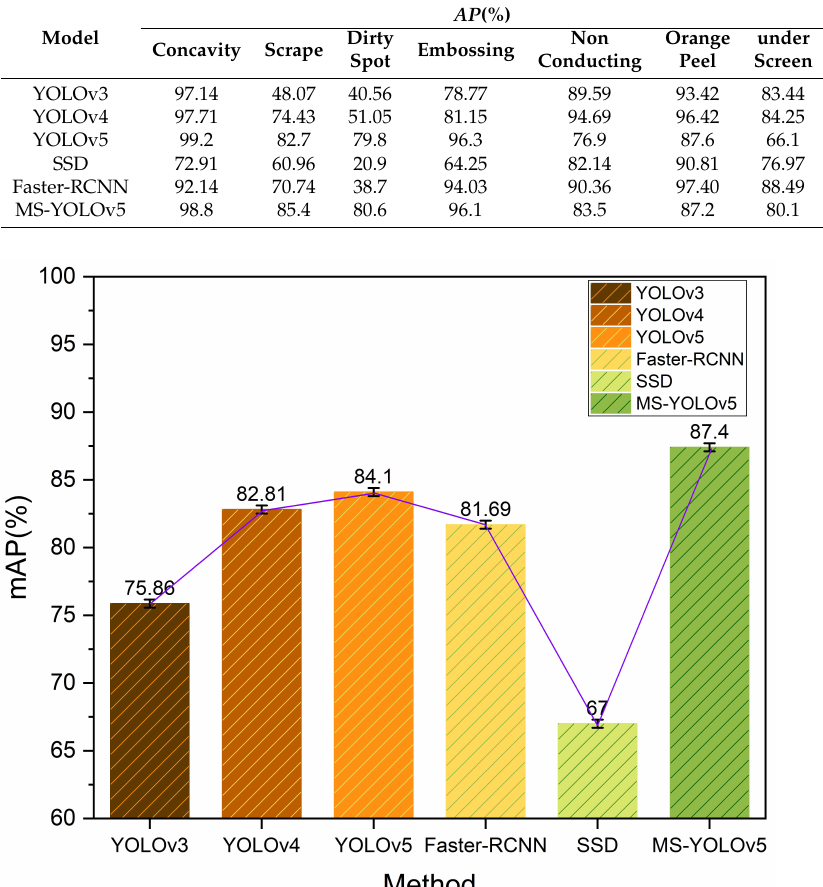
Figure 15. Comparison chart of mAP using six different